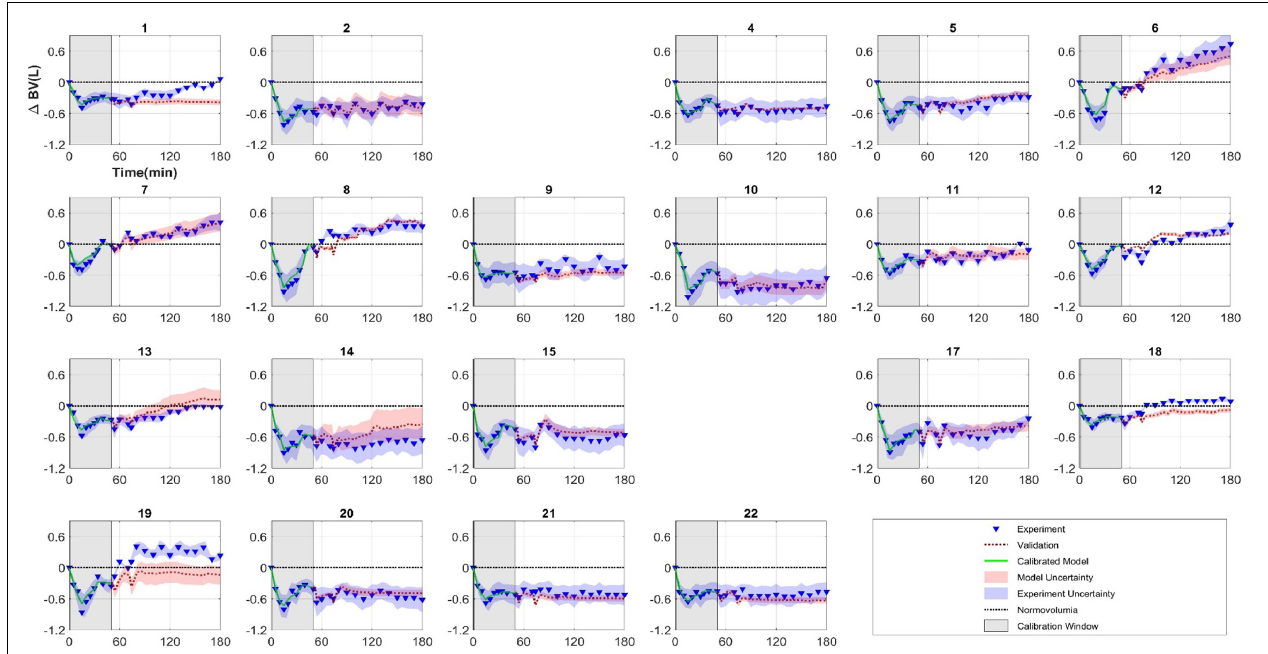
FIGURE 6 | Subject-specific model calibration and validation. Each figure represents a different animal (subjects 3 and 16 were excluded because parameters were not identifiable for these subjects). Model was calibrated to experimental data between 0 and 50 min (model: green line, experiment: triangles). Model was then simulated from 50 to 180 min (red dashed line) and can be compared against experimental measurements (triangles) (model validation). Shaded regions represent 95% confidence